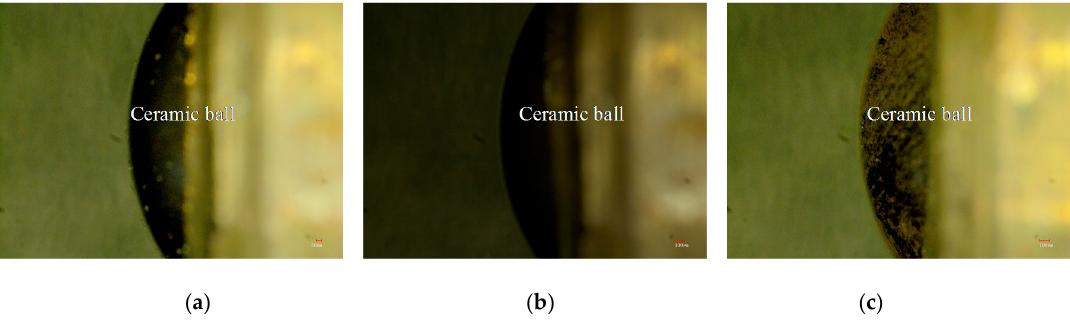
Figure 15. Worn morphologies of friction-pairs on Cr–Ni coatings with different mass ratios of Cr and Ni. ( a ) Worn morphology of friction-pair on 17% Cr–83% Ni coating; ( b ) Worn morphology of friction-pair on 20% Cr–80% Ni coating; ( c ) Worn morphology of friction-pair on 24% Cr–76% Ni coating.